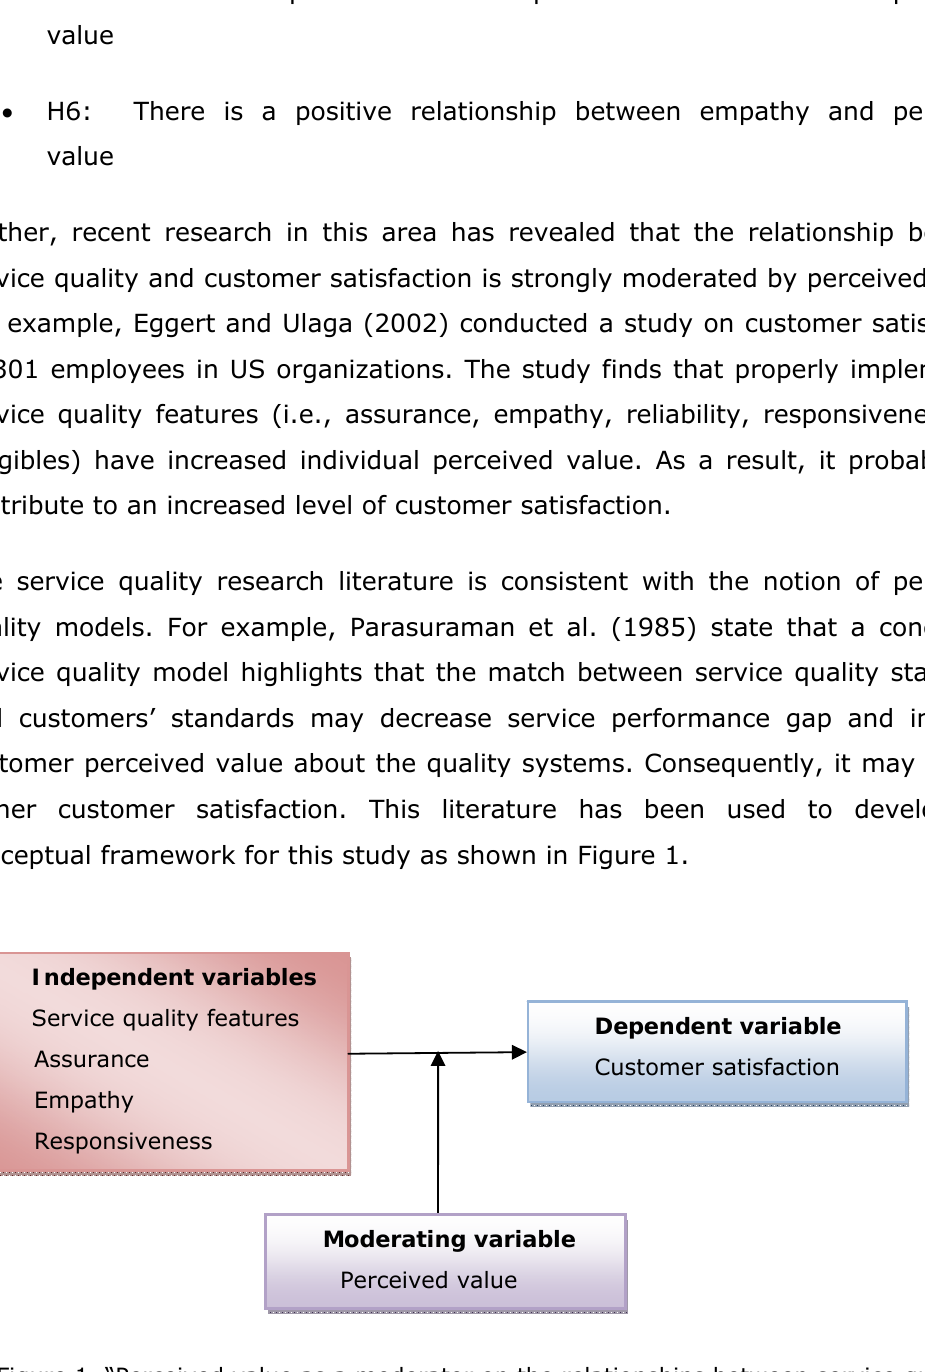
Figure 1. “Perceived value as a moderator on the relationships between service quality features and customer